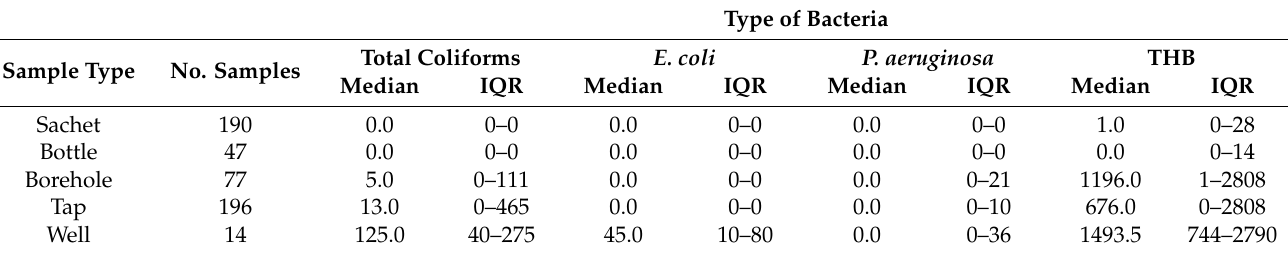
Table 2. Bacterial load (cfu/100 mL) of various drinking water samples from Greater Accra